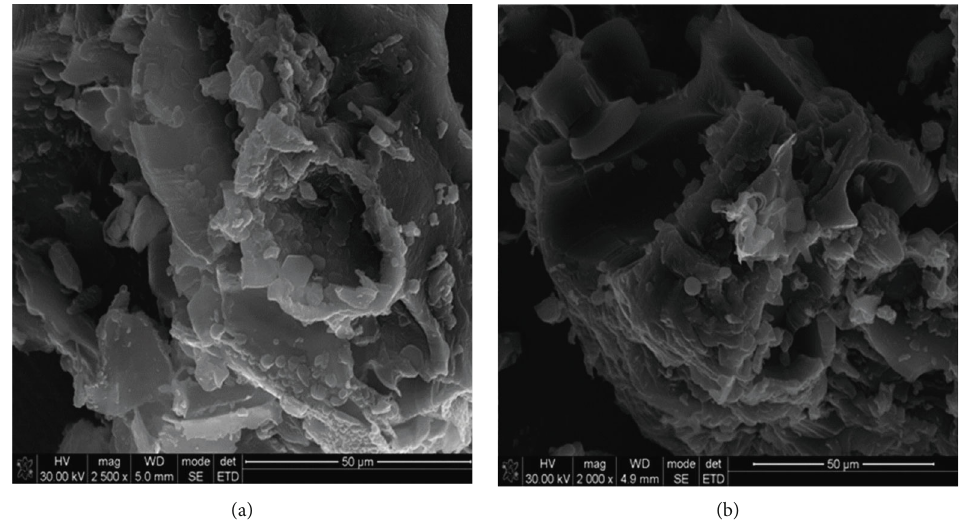
Figure 8: FESEM micrographs (a) PP-AC and (b)